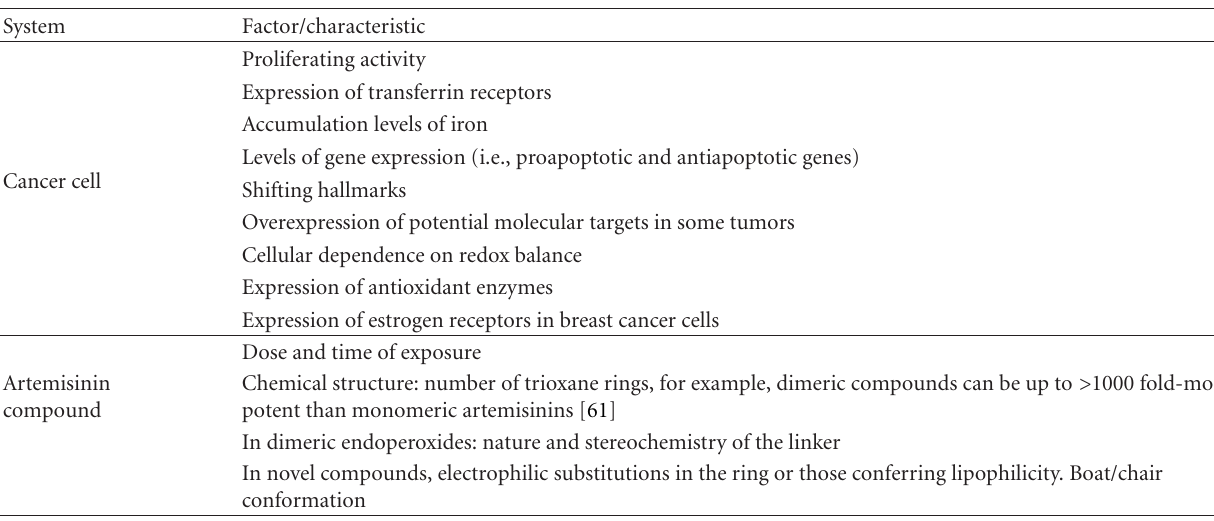
Table 1: Factors that may influence artemisinins response in cancer